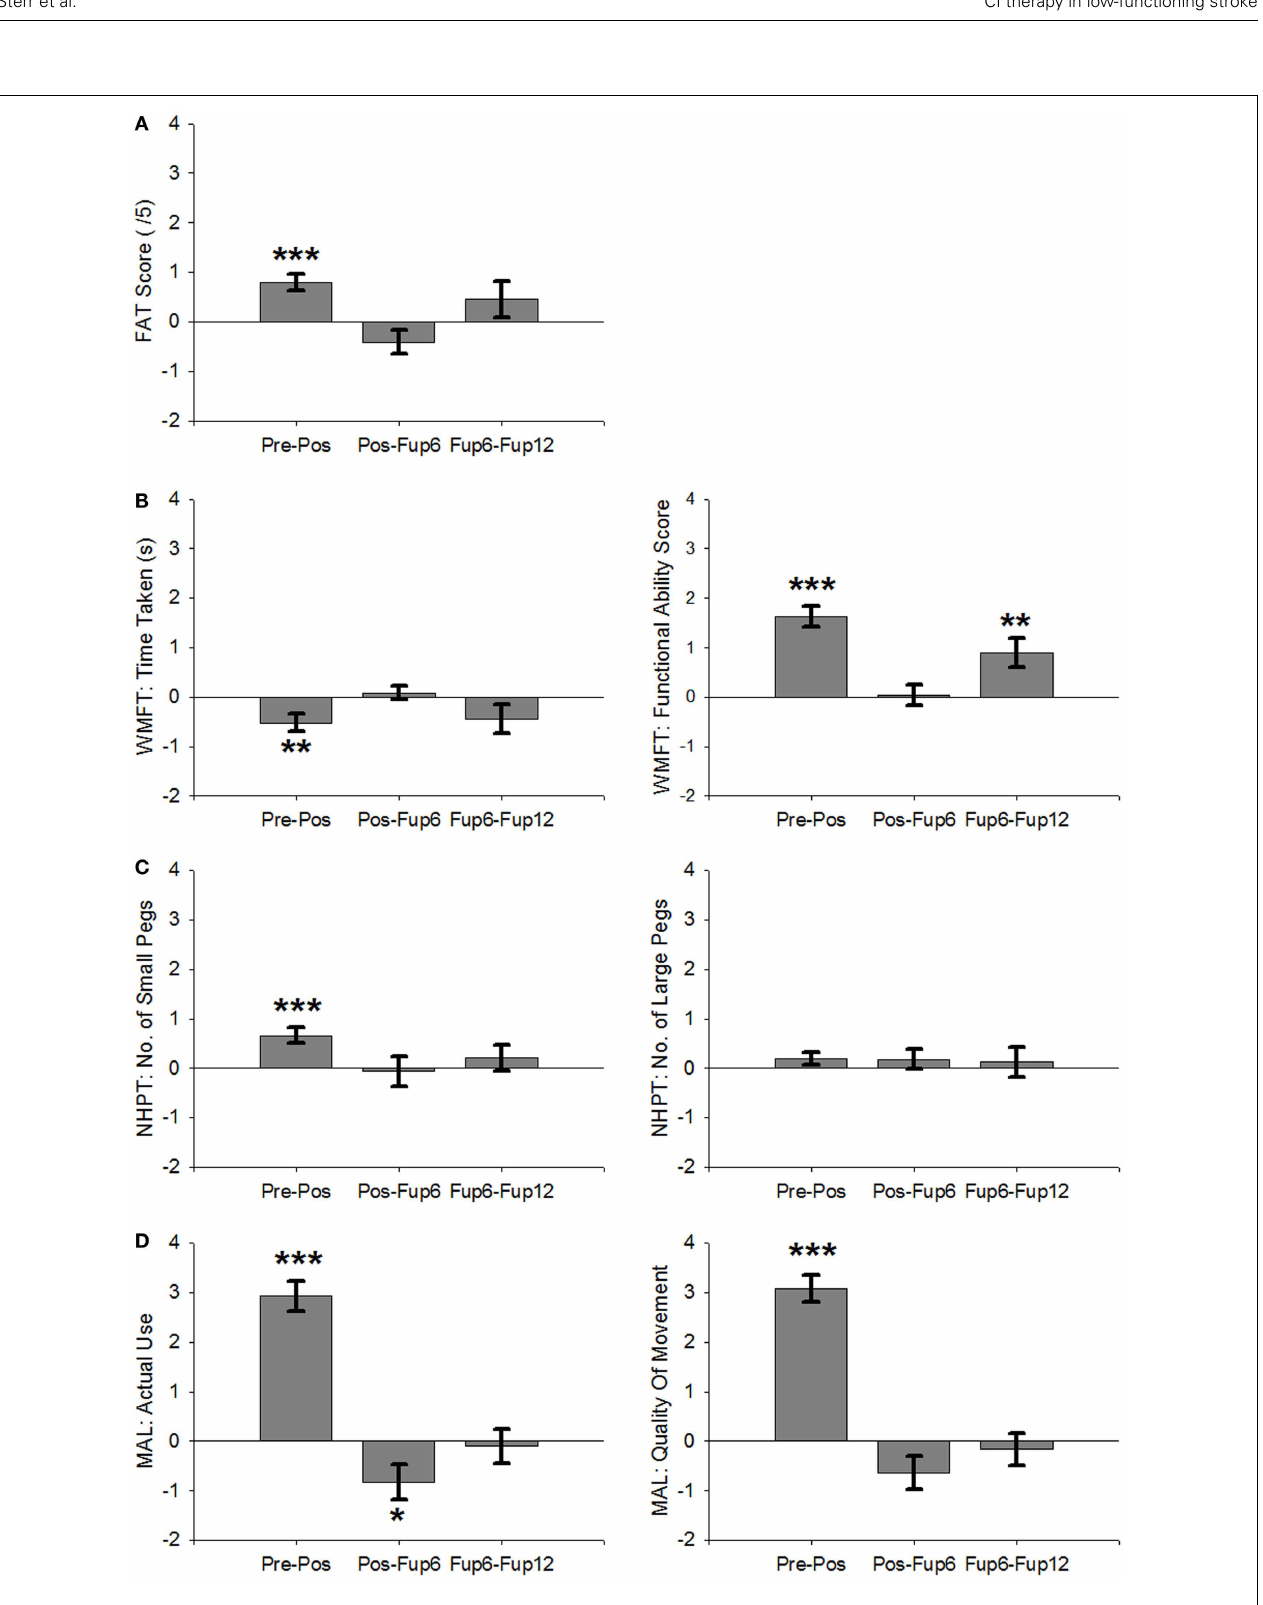
of small pegs (left) and large pegs (right). (D) Motor Activity Log: Amount of Use (left) and Quality of Movement (right). Error Bars are SEM. *** p < 0.001, ** p < 0.01, * p <